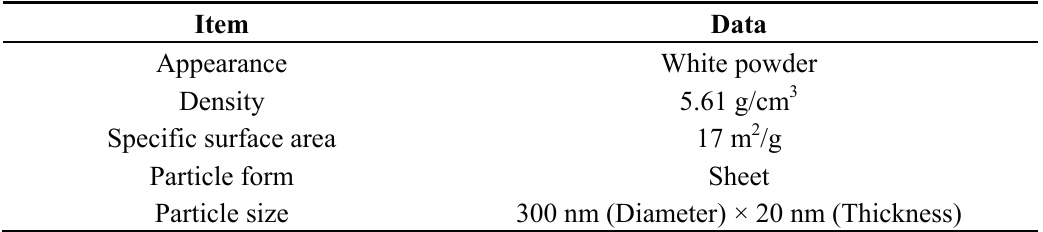
Table 2. Geometry and material properties of ZnO powder.